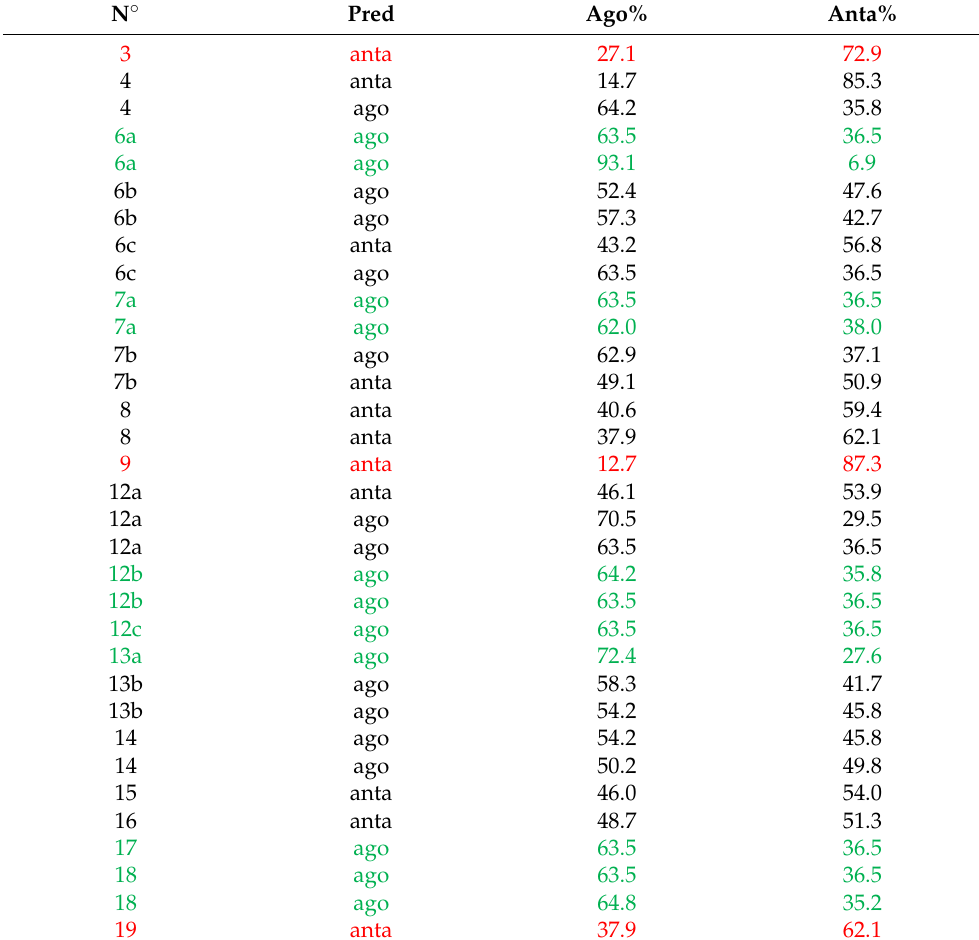
Table 1. Prediction obtained by PF model a